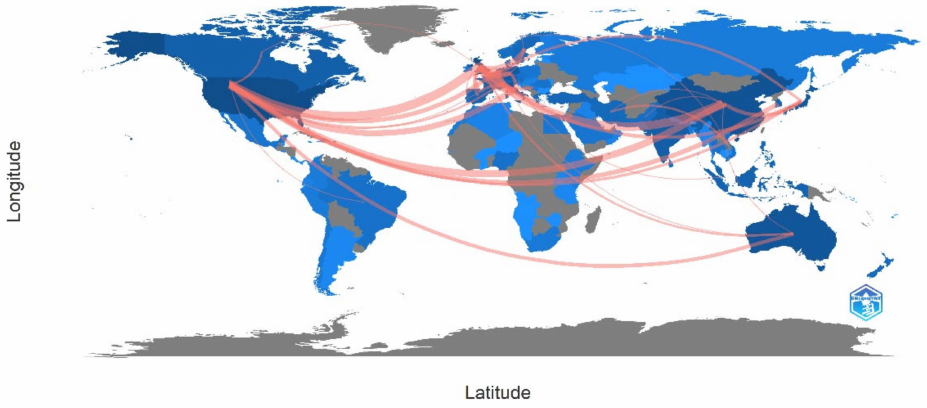
Figure 5. Country collaboration map.